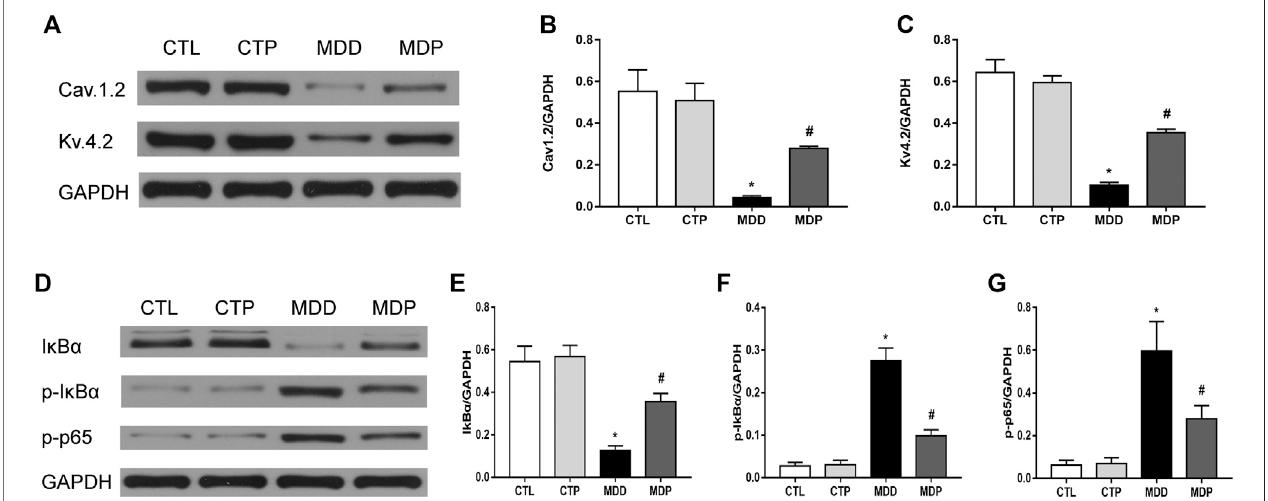
FIGURE 9 | Western blot. (A – C) Immunoblotting and expression ratio of Cav1.2 and Kv4.2, respectively. n (cid:1) 7 per group. (D – G) Immunoblotting and expression ratio of I κ B α , p-I κ B α , and p-p65, respectively. n (cid:1) 7 per group. * p < 0.01 vs. CTL; # p < 0.01 vs. MDD.